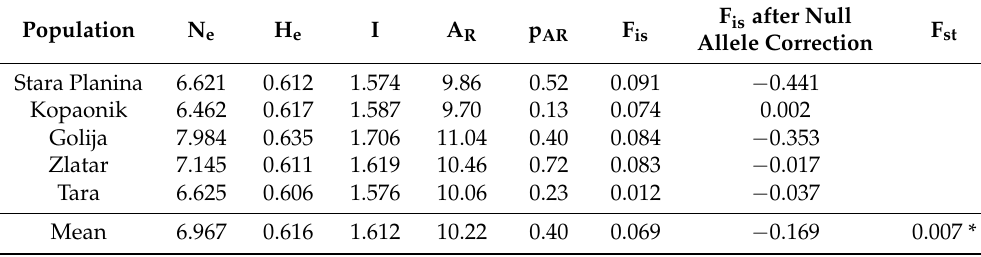
Table 4. Genetic diversity parameters at the population level based on five loci: N e (number